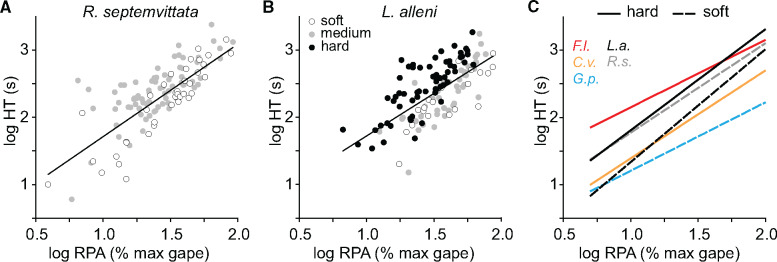
Prey HTs versus RPA for crustacean-eating snakes. Regressions for the entire sample of intact crayfish consumed by (A) R. septemvittata (n = 118) and (B) L. alleni (n = 127) in the laboratory. (C) Regressions of HT versus RPA performed separately based on molt status (solid versus dashed lines) for: R.s., R. septemvittata eating O. rusticus; L.a., L. alleni eating P. fallax; F.l., Fordonia leucobalia eating crabs swallowed side to side; G.p., Gerarda prevostiana eating crabs swallowed front to back; C.v., Cantoria violacea eating snapping shrimp. See Table 1 for regression statistics for the crayfish-eating species. The homalopsid data are from Jayne et al. (2018).